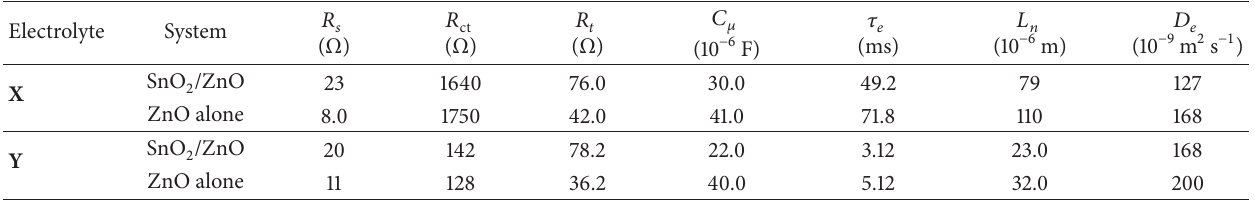
Figure 6: (a) UV-visible absorption spectra of indoline D358 dye in 1: 1 volume ratio of acetonitrile/tert-butyl alcohol (solid line) and system consists of dye/ZnO/SnO 2 film on the FTO substrate (dotted line) and (b) disrobed dye solution from 1cm × 1cm films. Table 4: Electron lifetime, charge transport time, chemical capacitance, and resistance values obtained for each composite system of the DSCs with electrolytes X and Y